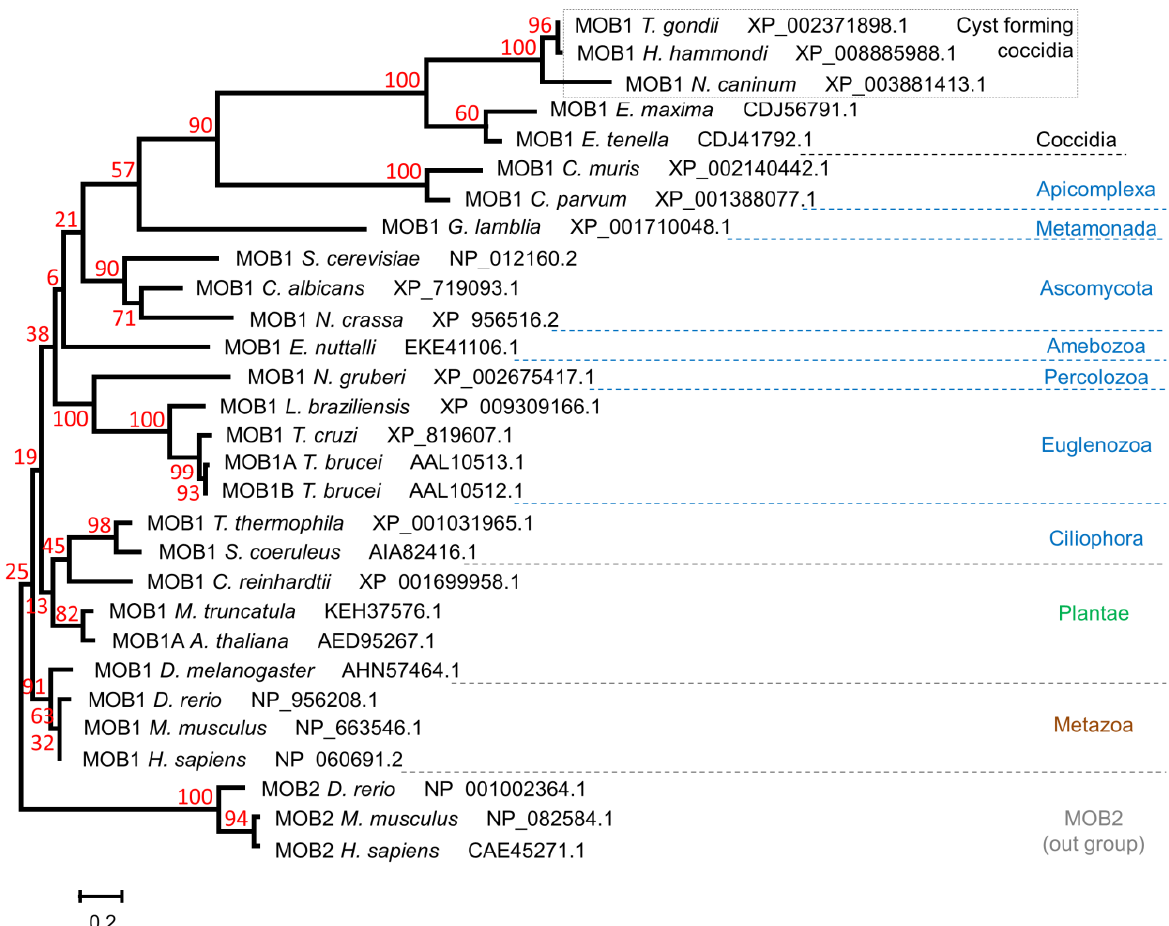
Figure 2. Phylogenetic analysis of MOB1 proteins from different parasitic organisms. The predicted amino acid sequence of T. gondii MOB1 and those of different parasitic organisms were compared with MOB1 proteins from model organisms throughout the eukaryotic tree of life. The sequences were aligned and used to perform a maximum likelihood phylogenetic analysis. Kingdom (brown and green), phylum (blue), and ad hoc cluster names (black) are indicated on the right side. Bootstrap values are presented in red. The scale bar indicates the estimated number of amino acid substitutions per site.